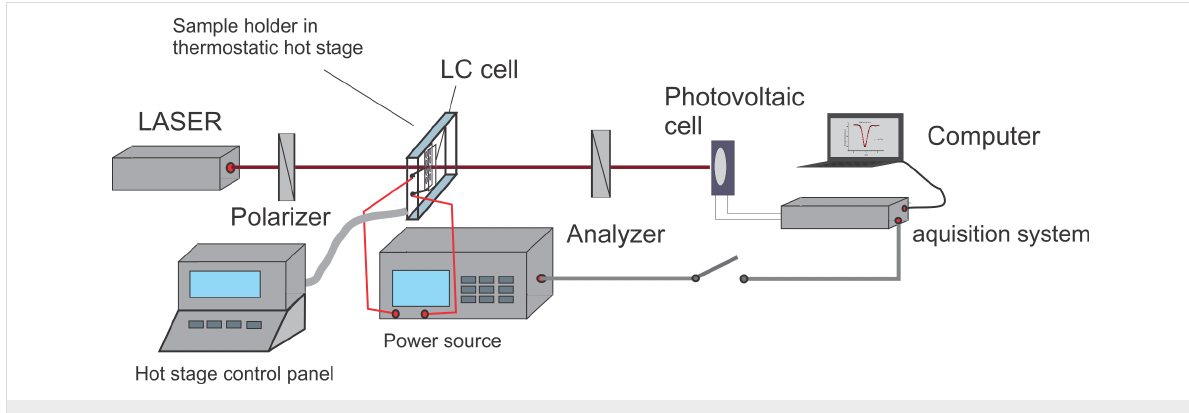
Figure 5: Experimental setup for the dynamic study of LC + SWCNTs in an electric field.